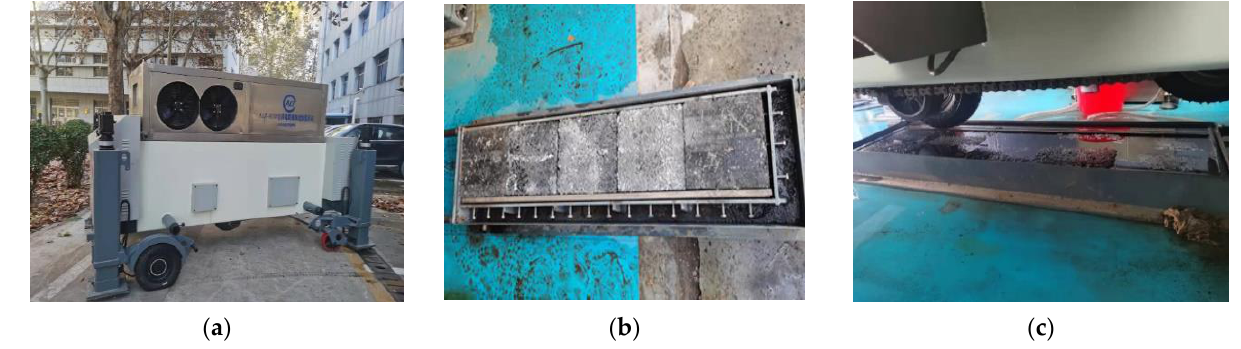
Figure 3. Test equipment and specific working conditions. ( a ) Accelerated loading test device; ( b ) Specimen layout; ( c ) High-temperature water area test. ( b ) Specimen layout; ( c ) High-temperature water area